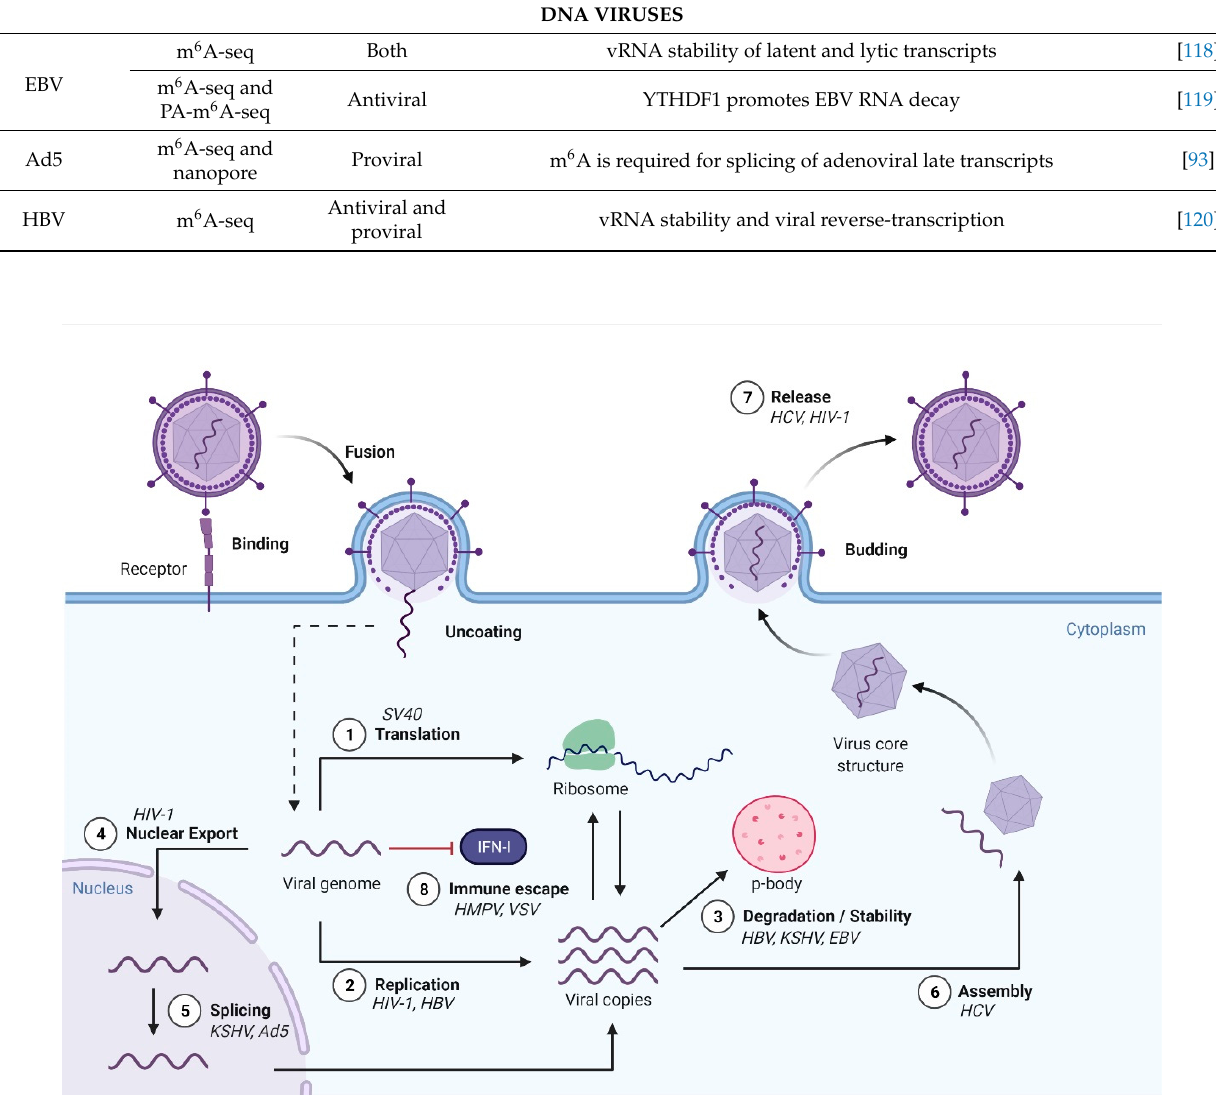
Figure 3. How viral m 6 A modifications and the host m 6 A machinery affect viral replication. Both DNA and RNA viruses are subjected to extensive m 6 A modification. Importantly, m 6 A modifications differentially impact the steps of the viral life cycles depending on the virus. (1) m 6 A modifications enhance the translation of some viral mRNAs. (2) m 6 A modifications prevent replication through the inhibition of reverse transcription in retroviruses and enhance replication of HBV through the facilitation of reverse transcription. (3) m 6 A modifications reduce or increase viral mRNA stability. (4 and 5) m 6 A modifications affect the splicing and nuclear export of some viral RNAs that replicate in the nucleus. (6) The encapsidation of genomic RNA or assembly of viral components can be regulated by m 6 A modifications. (7) m 6 A modifications reduce or increase infectious viral titers. (8) Viral m 6 A decorations can prevent virus-sensing by RIG-I or MDA5 receptors and consequently inhibit type I IFN induction and anti-viral